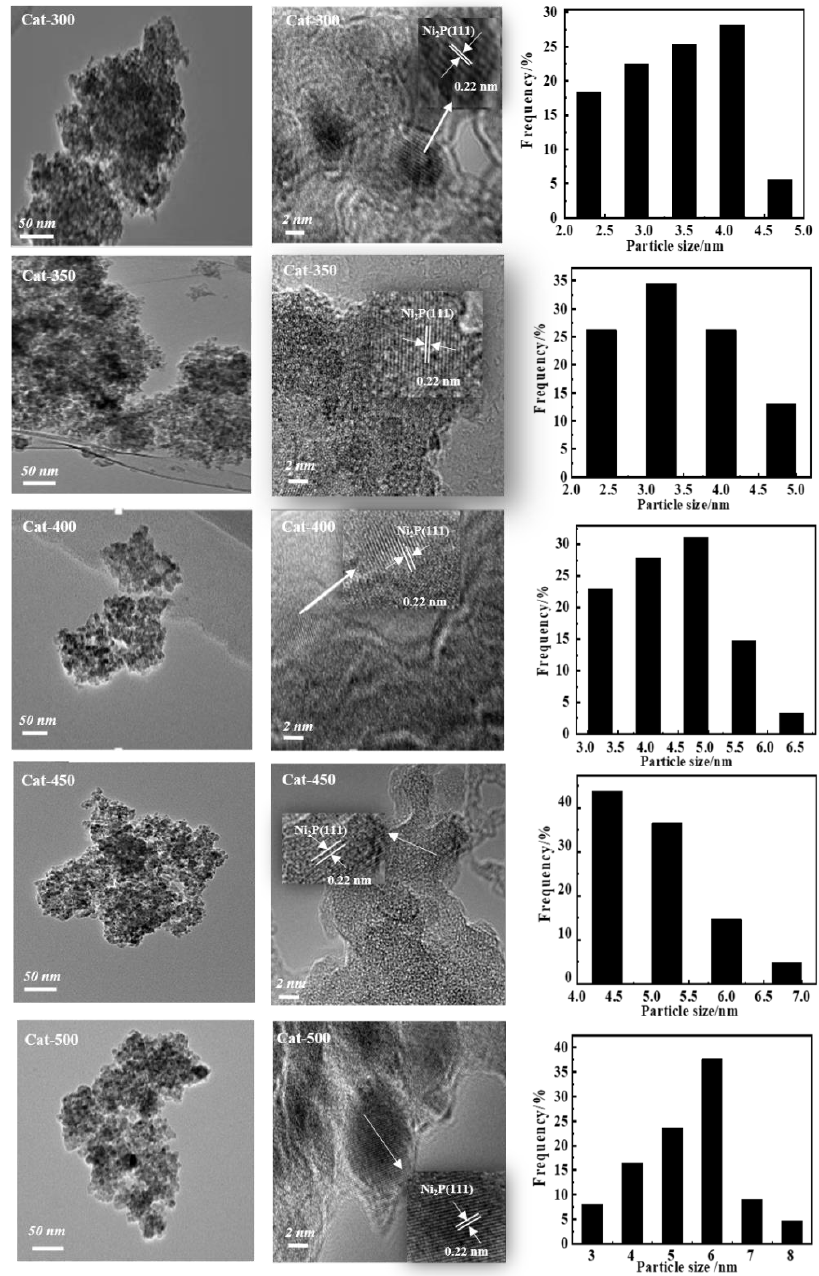
Figure 2. TEM micrographs of different Ni 2 P/Al 2 O 3 catalysts. Table 1. Ni δ+ and P δ− peak area of different Ni 2 P/Al 2 O 3 catalysts.